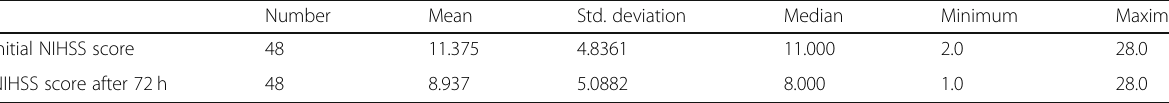
Table 1 Stroke severity on admission and after 72 h regarding NIHSS score